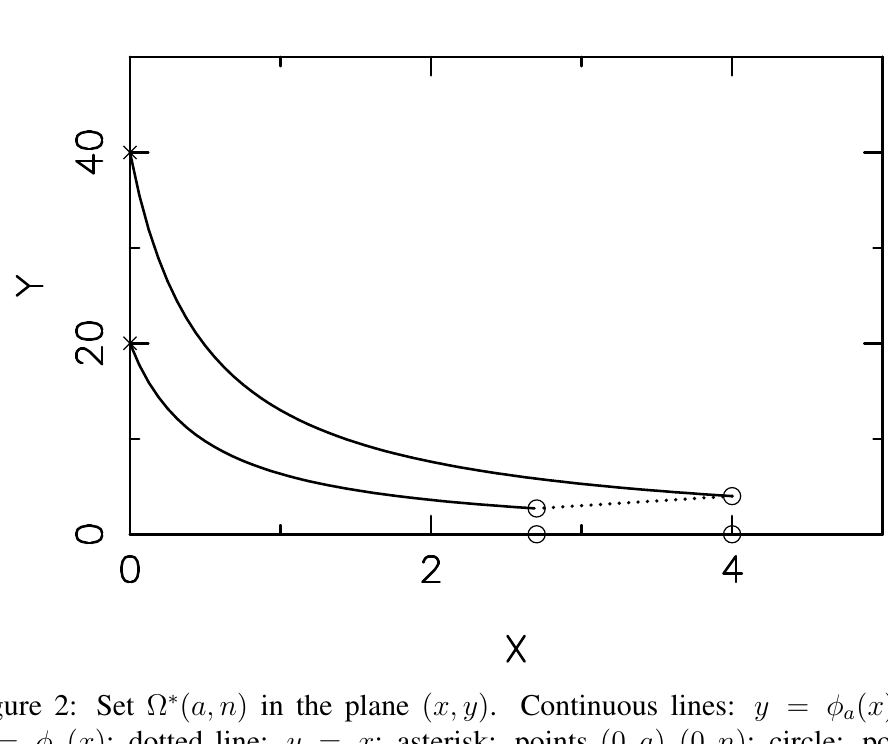
Figure 2: Set Ω ∗ ( a, n ) in the plane ( x, y ) . Continuous lines: y = φ y = φ ( x ) ; dotted line: y = x ; asterisk: points (0 , a ) , (0 , n ) ; circle: points n ( I , 0) , ( I , 0) , and corresponding points on the curves. Different scales for x and a n y